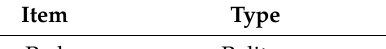
Table 1. Specifications of the pad and slurry.